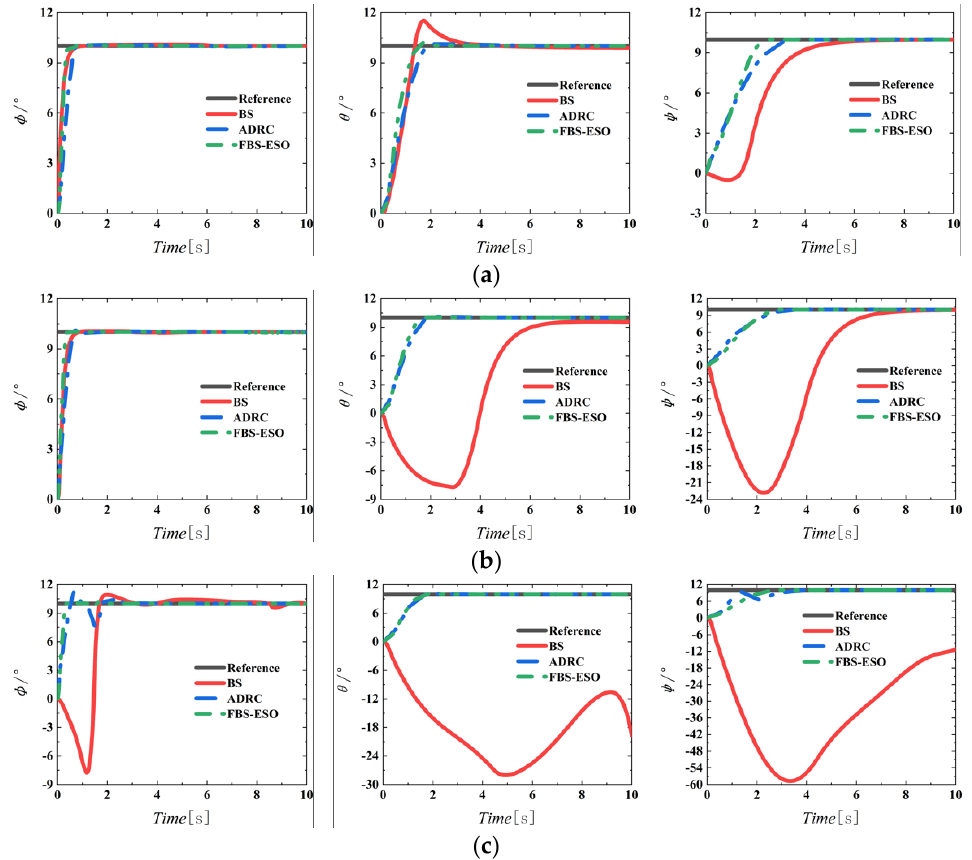
Figure 9. Response curves of the robustness tests. ( a ) β t = 90 ◦ (helicopter mode); ( b ) β t = 45 ◦ (transition mode); and ( c ) β t = 0 ◦ (fixed-wing